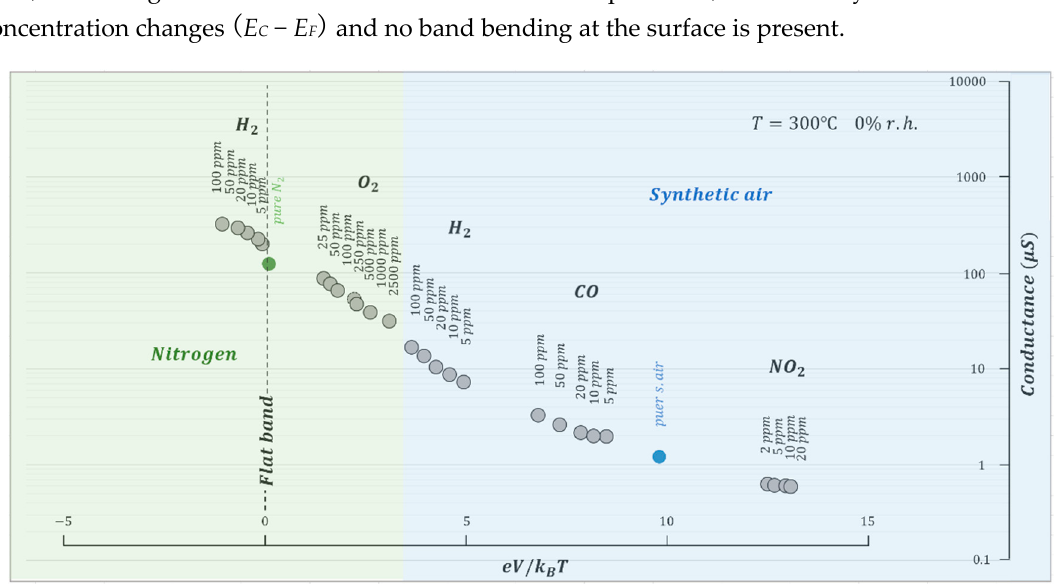
Figure 1. Conductivity against relative work function changes measured at 300 ° C with no humidity present. The 𝜑 measured in nitrogen is taken as the flat band condition. The green and blue area represent the carrier gas